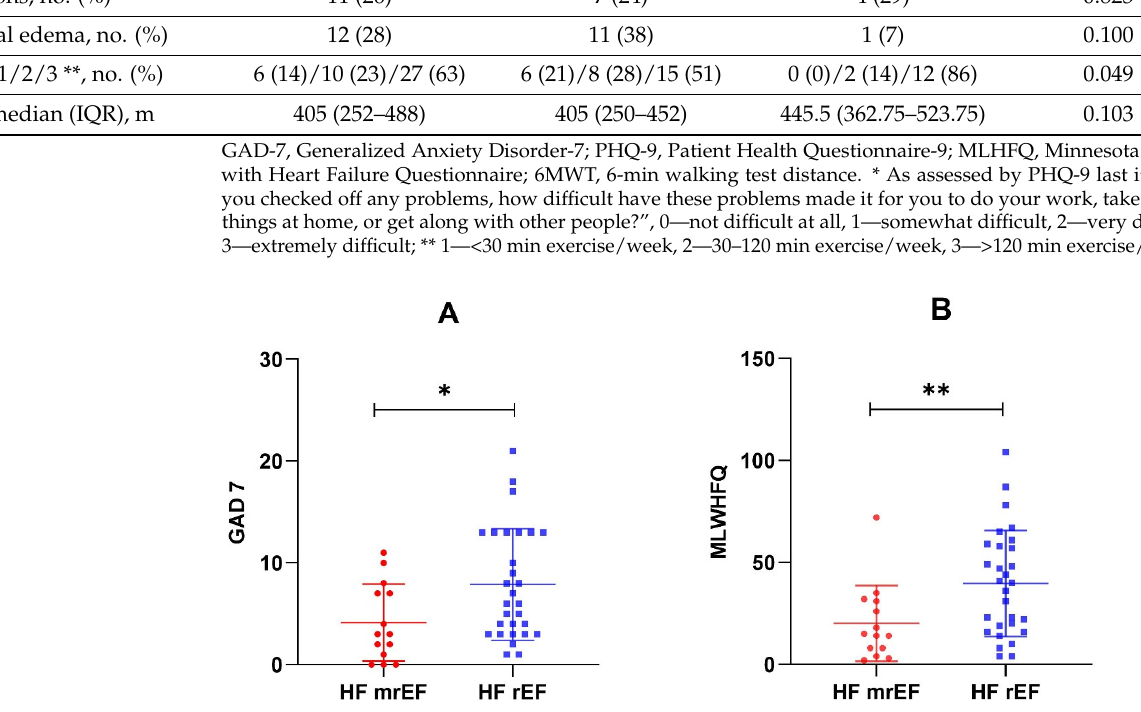
Figure 1. GAD-7 scores ( A ) and MLHFQ scores ( B ) in the two EF subgroups. * p = 0.026; ** p = 0.009.